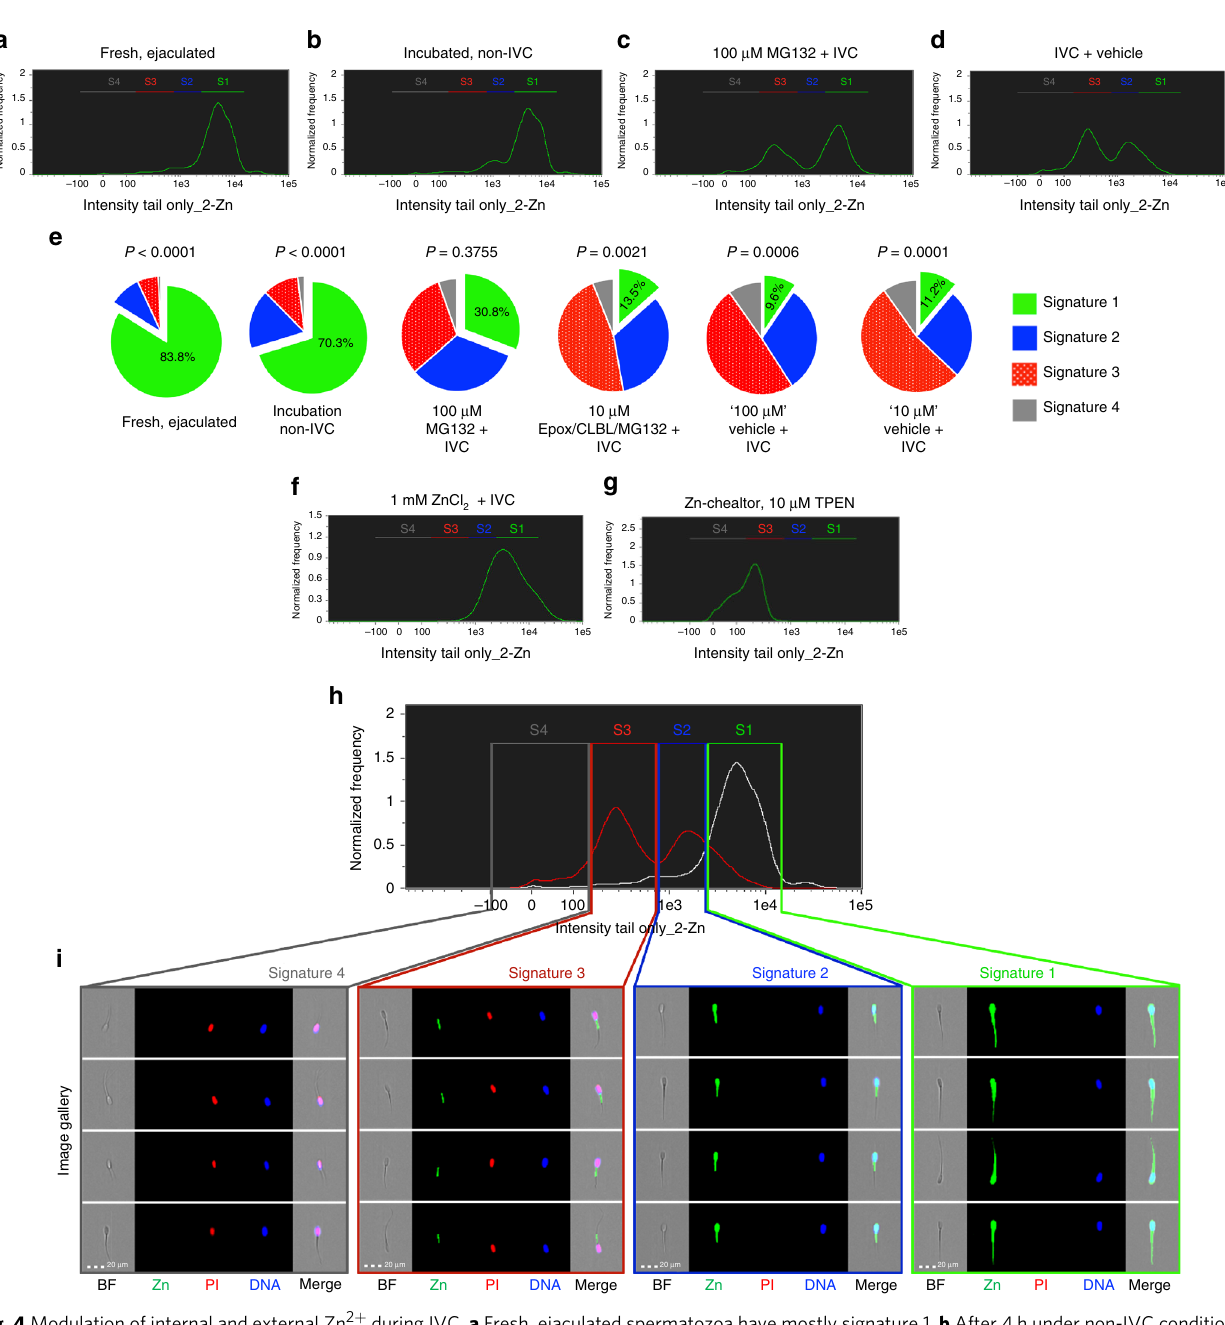
Fig. 4 Modulation of internal and external Zn 2 + during IVC. a Fresh, ejaculated spermatozoa have mostly signature 1. b After 4 h under non-IVC conditions, few spermatozoa underwent spontaneous early-stage capacitation. c Proteasomal inhibitor MG132 (100 µ M) prevented some of the IVC-induced zinc signature changes compared to d (IVC with MG132-vehicle); see Supplementary Fig. 2g for no vehicle IVC control. e Ten-micrometer Zn-chelator TPEN altered the zinc signature; see Supplementary Fig. 2h for TPEN vehicle treatment ( P -value by treatment across replicates). f Addition of 1 mM ZnCl 2 + IVC prevented IVC-induced zinc signature changes. g Pie chart illustration of select IVC treatments (green: signature 1; blue: signature 2; red: signature 3; gray: signature 4). Treatment P -values are shown in Table 2 as determined by the general linear model procedure in SAS 9.4. 10,000 sperm per sample analyzed. h Histograms of non-capacitated (non-IVC, white) and capacitated (IVC, red) sperm populations from IBFC analysis i Images from IBFC gallery representing individual zinc signatures (scale bar: 20 μ m). Each spermatozoon analyzed has the following images acquired: bright fi eld (BF); Zn 2 + reporting probe FZ3 (Zn); sperm viability/plasma membrane integrity probe propidium iodide (PI); live DNA stain Hoechst 33342 (DNA); and side scatter (not displayed), with a merger of the four images + penetration are present in the inner acrosomal membrane 43 , (the concentration in bovine IVF media has pre- Increased Zn 2 location believed to be the leading edge of the sperm head during viously been shown to inhibit fertilization 47 adding further sup- port to the effective role of the zinc shield. Based on the present ZP penetration), have been shown to have their activities reduced data, sperm zinc signature likely changes as the spermatozoa and/or inhibited by Zn (human and bovine sperm acrosin 44 , advance through the female reproductive tract and progress paddle fi sh acrosin-like activity 45 , and brain MMP2 activity 46 ).